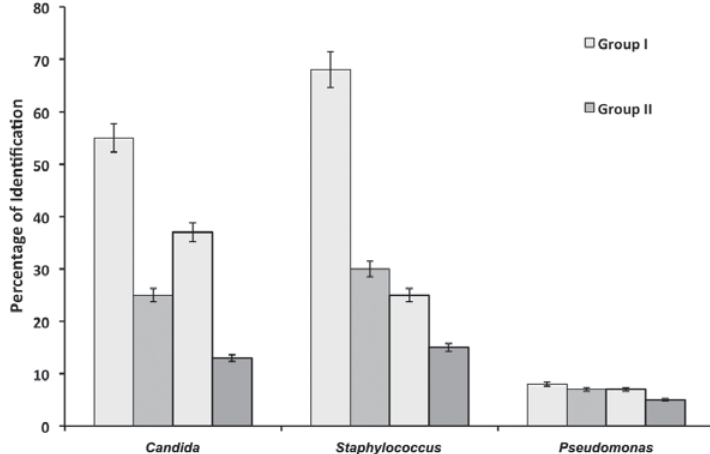
Figure 2- (cid:19)(cid:20)(cid:7)(cid:18)(cid:16)(cid:21)(cid:12)(cid:8)(cid:18)(cid:22)(cid:19)(cid:7)(cid:14)(cid:16)(cid:7)(cid:14)(cid:11)(cid:14)(cid:13)(cid:10)(cid:18)(cid:10)(cid:12)(cid:6)(cid:13)(cid:19)(cid:6)(cid:23)(cid:19)(cid:10)(cid:21)(cid:14)(cid:19)(cid:16)(cid:14)(cid:7)(cid:8)(cid:14)(cid:13)(cid:10)(cid:18)(cid:24)(cid:14)(cid:19)(cid:6)(cid:23)(cid:19)(cid:11)(cid:16)(cid:14)(cid:8)(cid:12)(cid:14)(cid:11)(cid:19)(cid:12)(cid:25)(cid:14)(cid:13)(cid:10)(cid:12)(cid:26)(cid:8)(cid:18)(cid:10)(cid:12)(cid:6)(cid:13)(cid:27)(cid:19)(cid:12)(cid:25)(cid:14)(cid:13)(cid:10)(cid:12)(cid:26)(cid:14)(cid:25)(cid:19)(cid:18)(cid:11)(cid:19)(cid:6)(cid:13)(cid:14)(cid:19)(cid:11)(cid:16)(cid:14)(cid:8)(cid:12)(cid:14)(cid:11)(cid:19)(cid:12)(cid:13)(cid:19)(cid:6)(cid:13)(cid:14)(cid:19)(cid:12)(cid:11)(cid:6)(cid:22)(cid:18)(cid:10)(cid:14)(cid:11)(cid:19)(cid:6)(cid:7)(cid:19) two species in same isolates were presented in two sets of group I & II in each species